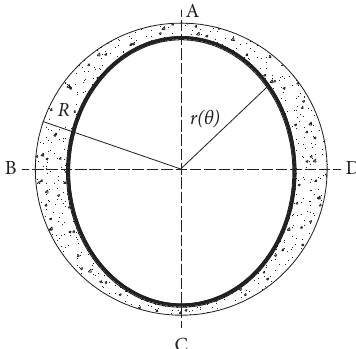
Figure 1: Schematic diagram of outer circle and inner ellipse shield tunnel